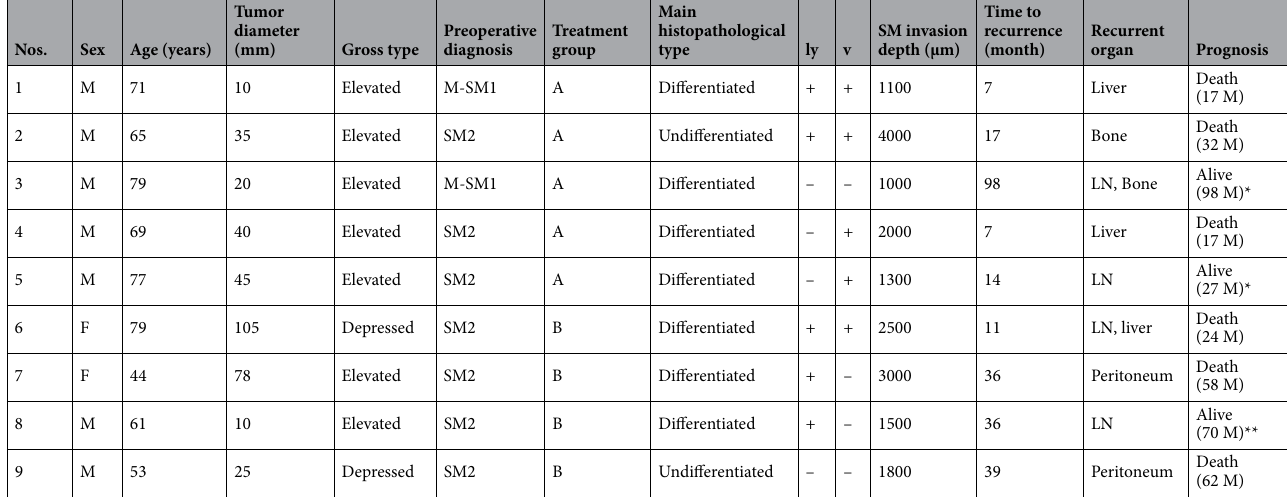
mucosal invasion ≥ 500 μm is, itself, a risk factor for LN metastasis. Several studies have reported the risk fac- tors for LN metastasis to be a positive vertical margin, submucosal invasion, lymphovascular invasion, venous invasion, and undifferentiated-type cancers 12,40–43 . The 2018 JGC Treatment Guidelines adopted the eCura as risk scoring system for LN metastasis 1 . The eCura system included 5 clinicopathologic factors, with 3 points for lymphatic invasion and 1 point each for tumor size > 30 mm, positive vertical margin, venous invasion, and A depth of mucosal invasion ≥ 500 μm. A total score 0–1 is indicative of a low risk for LN metastasis, with a score